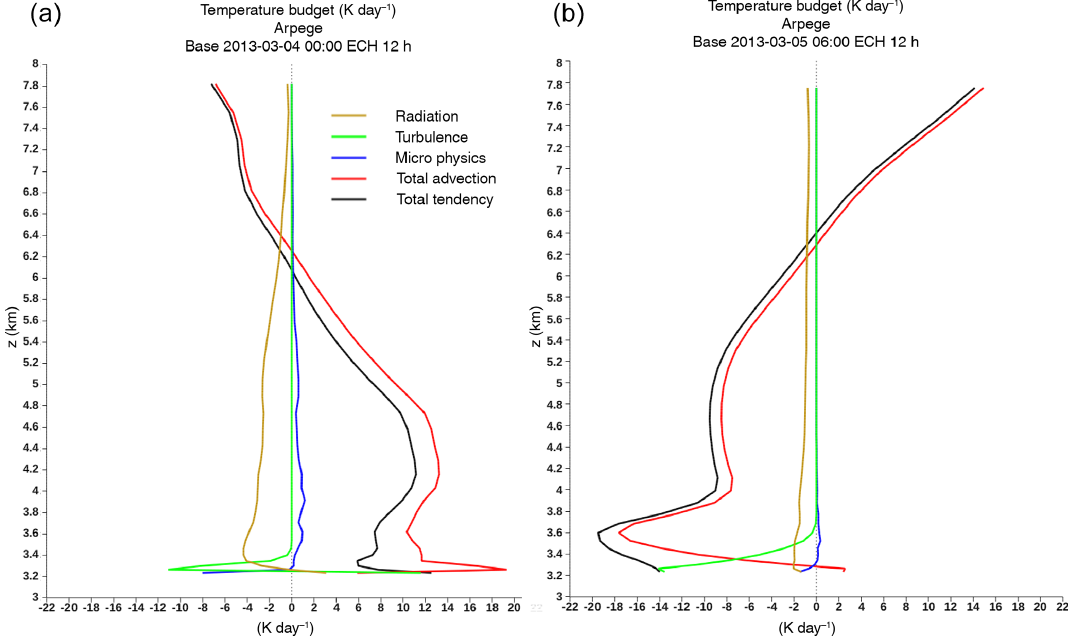
Figure 16. (a) Temperature budget calculated by ARPEGE on 4 March 2013 over the 12h period 00:00–12:00UTC induced by radiation (brown), turbulence (green), microphysics (blue) and total advection (red), showing the total tendency (black). (b) Same as (a) but on 5 March 2013 over the 12h period